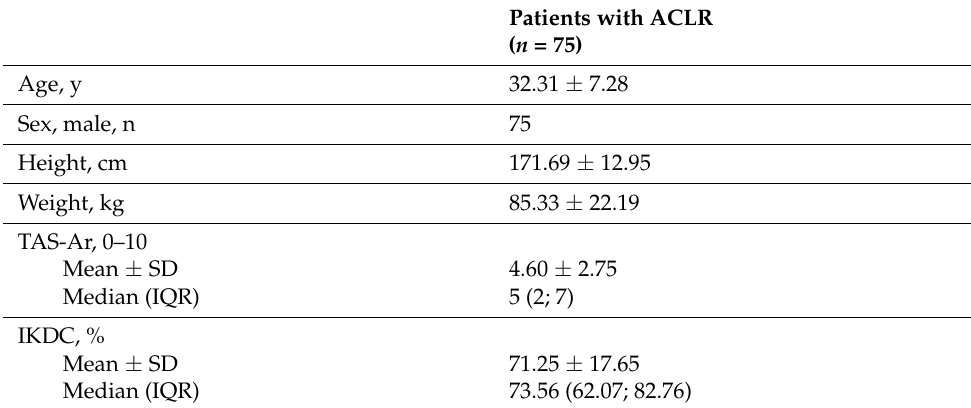
Figure 1. Flow diagram illustrating enrollment of patients with ACLR. Table 2. Demographic and clinical characteristics of the participants *.